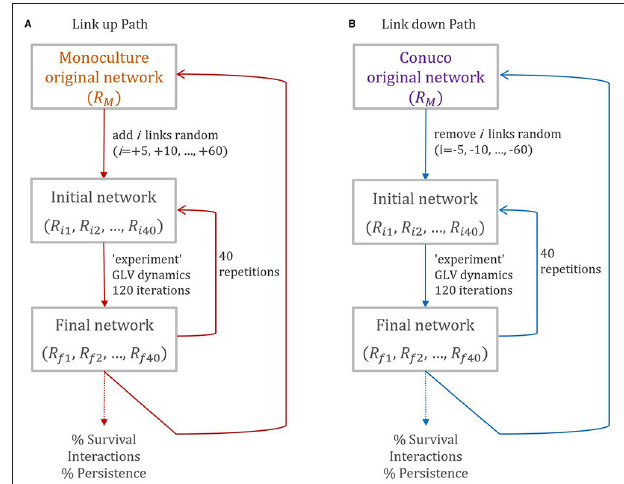
FIGURE 4 | Schematic representation of the simulation process, for Link up (A) and Link down (B) paths. At each step data is registered, for each network, R x = R x (number nodes, number of links, connectance, centrality, transitivity, reciprocity), and for each experiment (percentage of population survival, types of interactions, percentage of